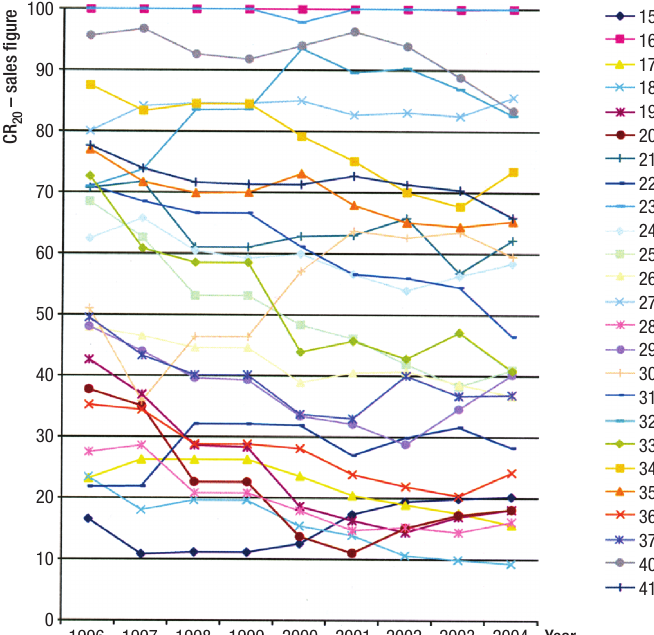
Fig. 3. CR evolution – sales fi gure during 1996–2004 20